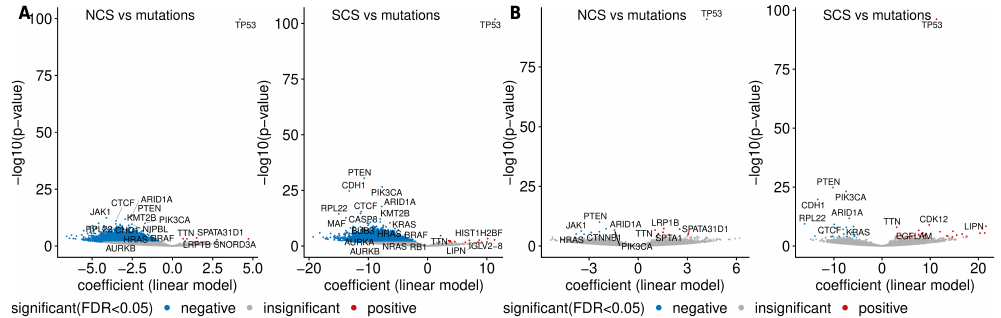
Figure 4. Pan-cancer somatic mutations and CIN. ( A ) The volcano plots show the association between somatic mutations and the NCS (left) or the SCS (right). The linear model coefficient indicates the mean difference of the respective CIN score when the mutation is present in a tumour sample relative to the wild type. Genes with lowest p -values, well-known CIN genes and cancer driver genes are highlighted. The analysis was performed on genes for which samples sizes for both wild type group and mutated group are larger than 19. Mutations significantly associated (FDR < 5%) with higher or lower CIN score are highlighted in blue and red, respectively. ( B ) The same as ( A ), but hypermutated MIN samples are